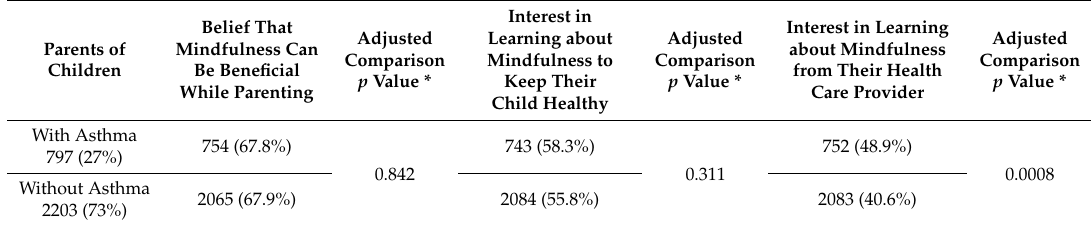
Table 2. Parents of children with and without asthma who indicated (agree or strongly agree) acceptance of learning about mindfulness.